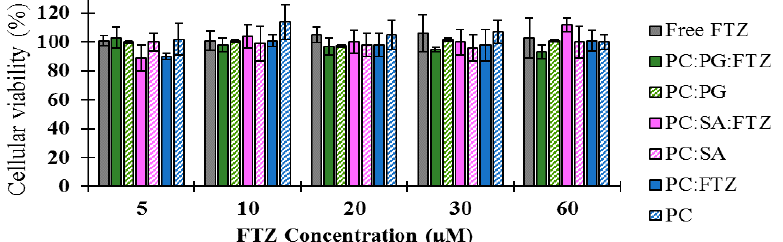
Figure 3. Cellular viability of A549 cells, 72 h after incubation with FTZ in the free form (Free FTZ), incorporated in liposomes [PC:PG:FTZ (N4, Table 2); PC:SA:FTZ (N3, Table 2); PC:FTZ (N1, Table 2)] or in unloaded liposomes (PC:PG; PC:SA; PC). FTZ tested concentrations ranged from 5 to 60 µM. Unloaded liposomes were also used as control using the same lipid concentrations as the ones used for the respective FTZ liposomal formulation. The obtained results are expressed as a mean ± SD of sextuplicate values for each concentration and formulation tested.